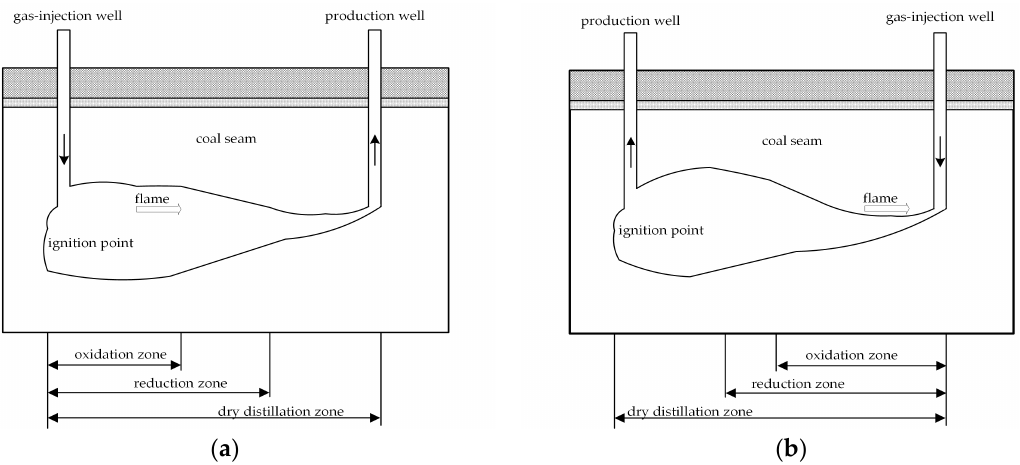
Figure 1. Schematic views of the three zones in forward and reverse underground coal gasification (UCG) processes. ( a ) Forward gasification; ( b ) reverse gasification.